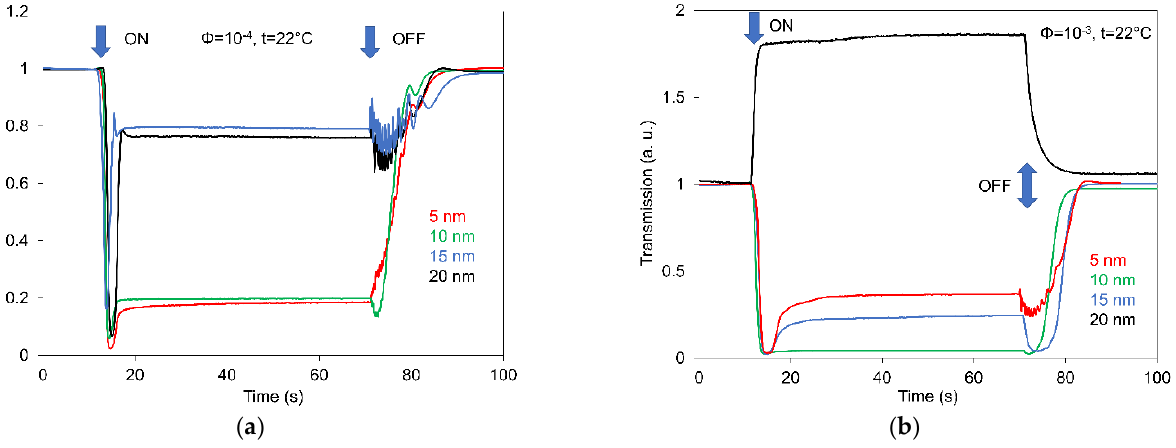
Figure 7. Comparing of light transmission time responses of 6CB doped with spherical magnetic nanoparticles of different sizes (5, 10,15 and 20 nm) after magnetic field 400 mT pulses were applied for two different concentrations, 10 −4 ( a ) and 10 −3 ( b ).